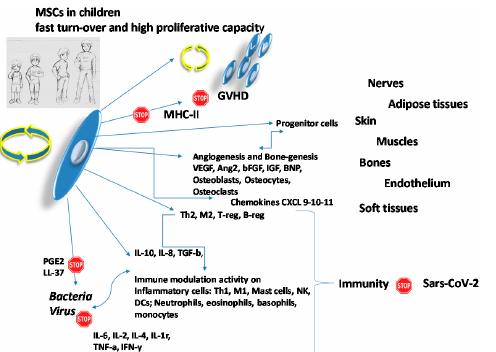
Figure 1. MSCs perform different activity. In young subjects these cells showed high rate of pro- liferation and turn-over. The MSCs in children, teenagers, and young adults are able to keep their status in differentiating state and secrete factors that can interact at different cellular processes, such as immunomodulation, chemoattraction, progenitor cell proliferation, angiogenesis, skeletal, and muscle genesis. Their fast differentiation capacity, their long telomeres keep the ACE2 receptors in uncompleted condition which does not allow the SARS-CoV-2 entrance, furthermore the high proliferation grade and their immune modulation ability may have an inhibitory effect on virus invasion